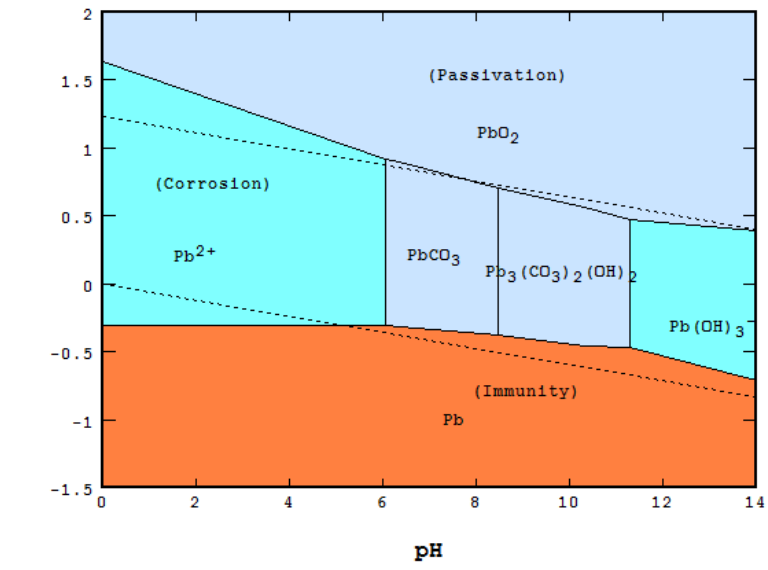
Figure 6. Eh-pH of the PbCO 3 –water system. [Pb] = 1 × 10 −6 and [CO 3 ] = 0.001 M. Pb carbonate phases do provide corrosion resistance.